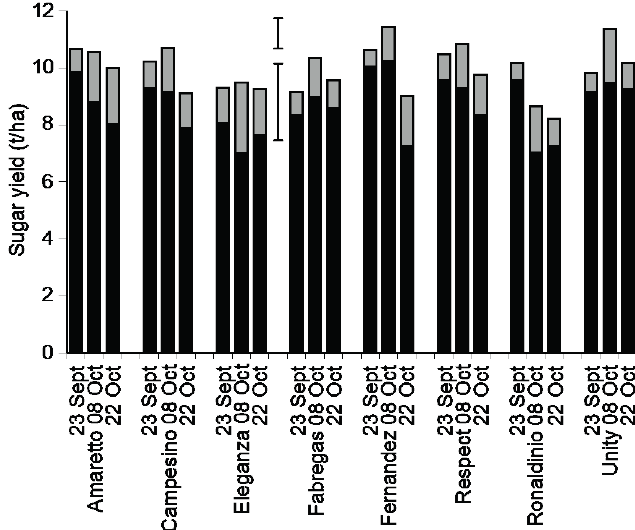
Fig. 2. Hydrolyzable (black bars) and free (grey bars) sugar content of 8 cultivars of maize harvested on 3 dates in 2010. Error bars show LSD of (upper bar) free sugars and (lower bar) hydrolyzable